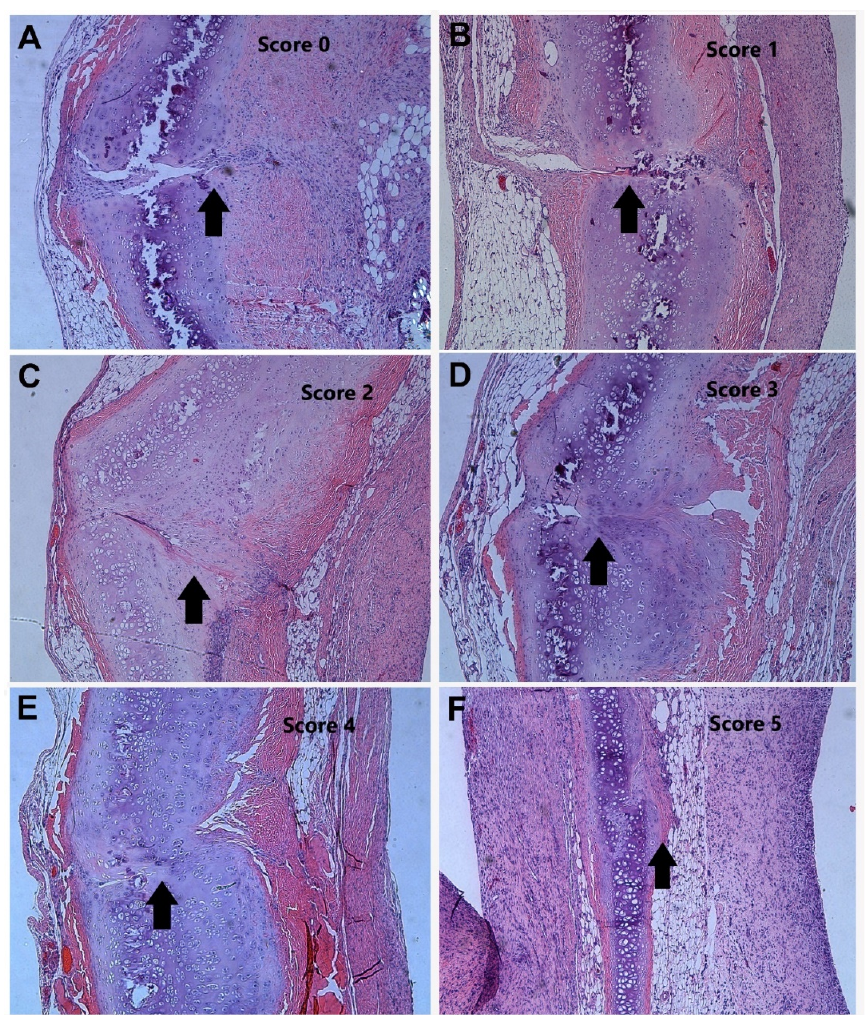
Figure 3. Typical examples of xyphoid cartilage tissue sections (H&E staining, 40×), representing the cartilage healing scores from 0–5 ( A – F ). Arrows indicate the cartilage healing.